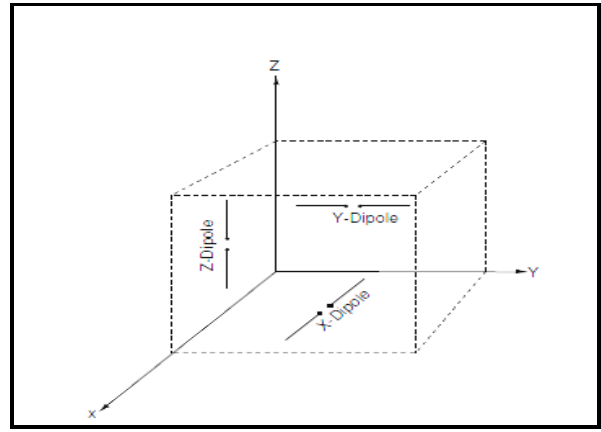
Figure 2: Three dipole elements orientation.